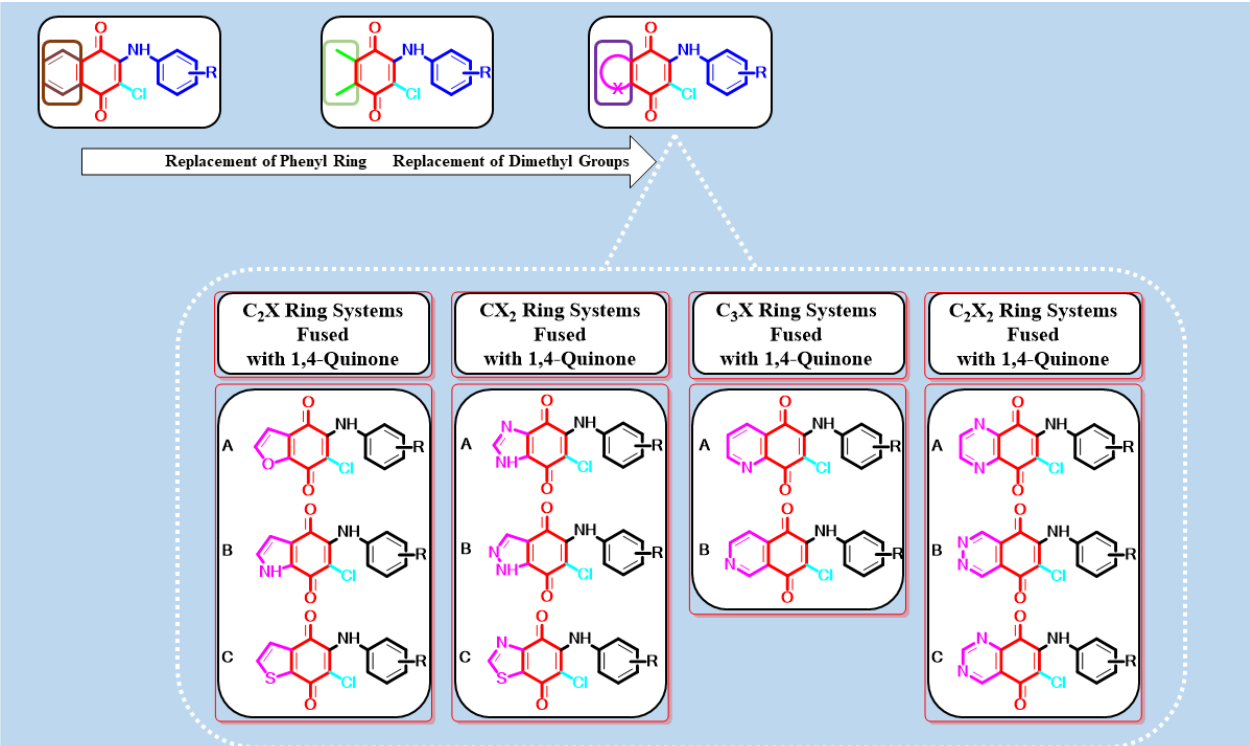
Figure 1. Design strategy for antimicrobial activity based on our previous studies and literature.